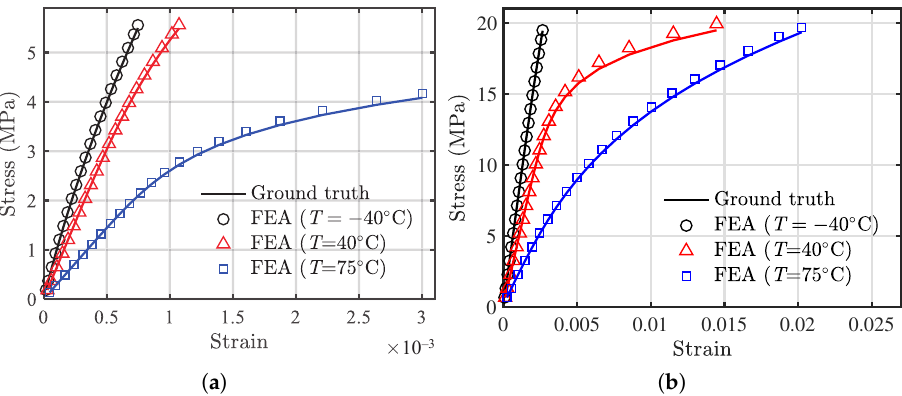
Figure 19. Comparison of FEA results and the proposed model at several temperatures. Solid lines represent ground truth by the proposed model, and discrete markers are numerical results extracted from FEA (user material). ( a ) Tension, and ( b )